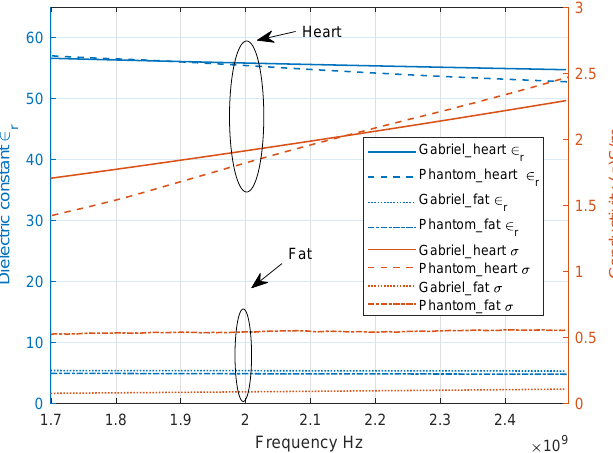
Figure 3. Dielectric Properties of ISM Phantom.